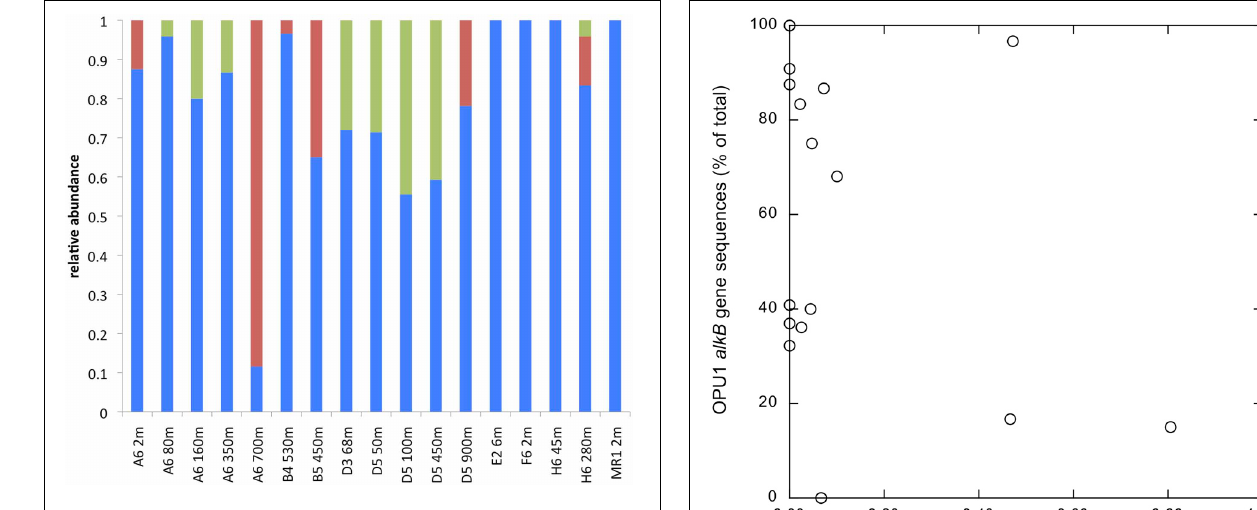
FIGURE 2 | Phylum level alkB composition by sample. Blue represents Proteobacteria, red represents Actinobacteria, and green represents unclassified.